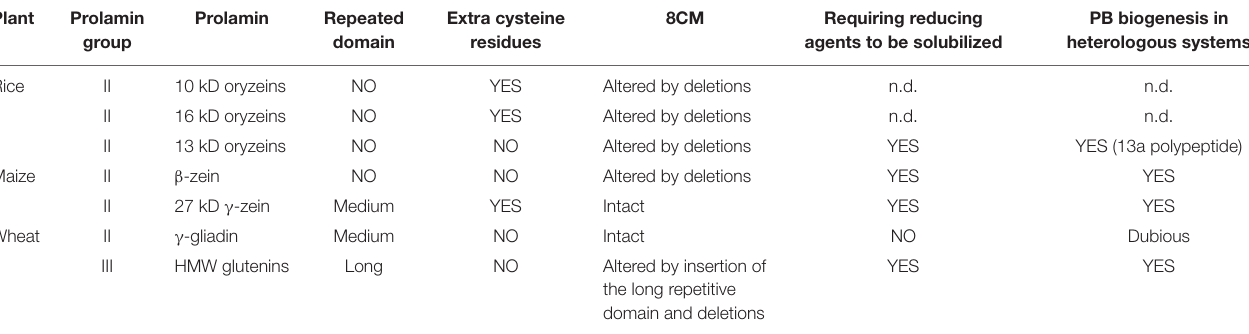
TABLE 1 | Summary of the main characteristics of the rice, maize, and wheat prolamins of group III and II (Xu and Messing, 2009) analyzed in this review.